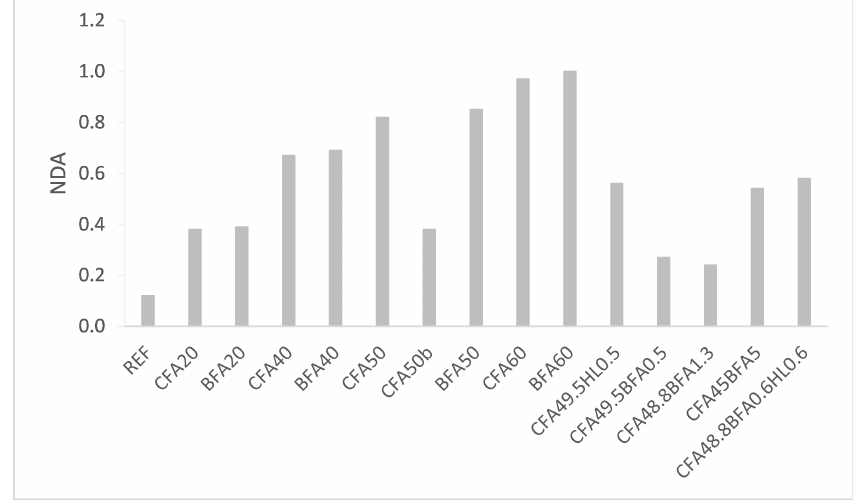
Figure 1. Normalized values that described the sustainability